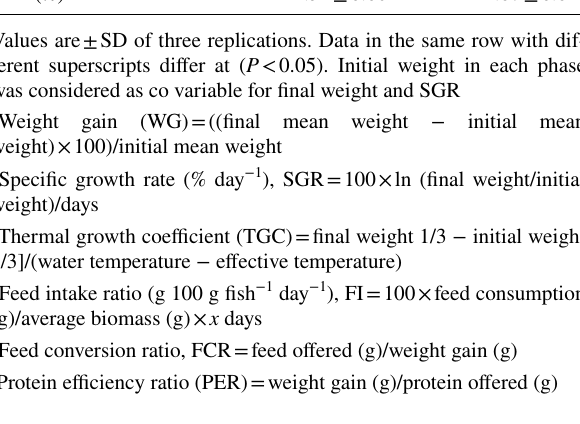
Table 3 Total amino acids of raw material and experimental diets